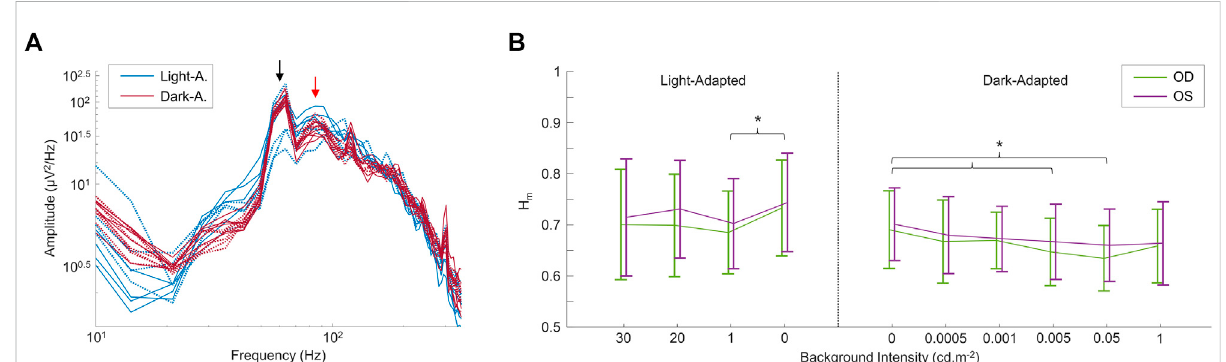
FIGURE 4 Comparing rsERGs at different background light intensities and retinal adaptation states. (A) Modi fi ed (removed 1/ f α background) and zoomed mean frequency spectrum depicted on a log-log scale for all light- (blue tracings) and dark-adapted (red tracings) rsERGs obtained from different background luminance. For the detailed tracings for each luminance, Supplementary Figure S2. Of note, both eyes are shown separately, with OD shown in full lines and OS in dashed lines. The red arrow shows the 90 Hz peak, while the black arrow shows the 60 Hz contamination, which was greater in these recordings than in those from Figure 3 (B) Values ± STD of the main exponent H m , for both light- and dark-adapted rsERGs at different background light intensities, and for both eyes. Statistically signi fi cant differences ( p < 0.05) between valuesin both eyes are shown with an asterix